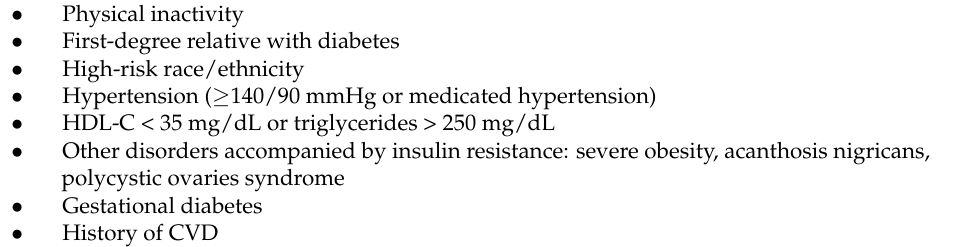
Table 2. Diabetes risk factors checklist for screening